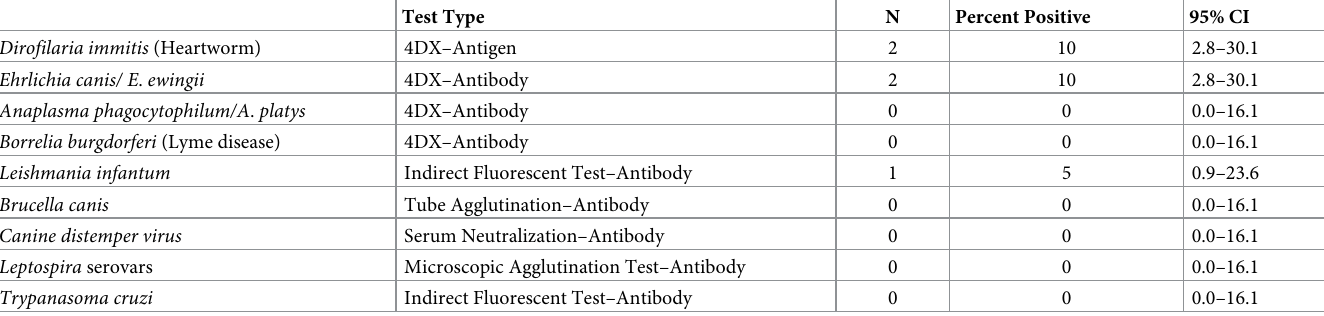
Table 2. Results from 4DX SNAP tests and serological tests from Waiwai domestic dogs (n =